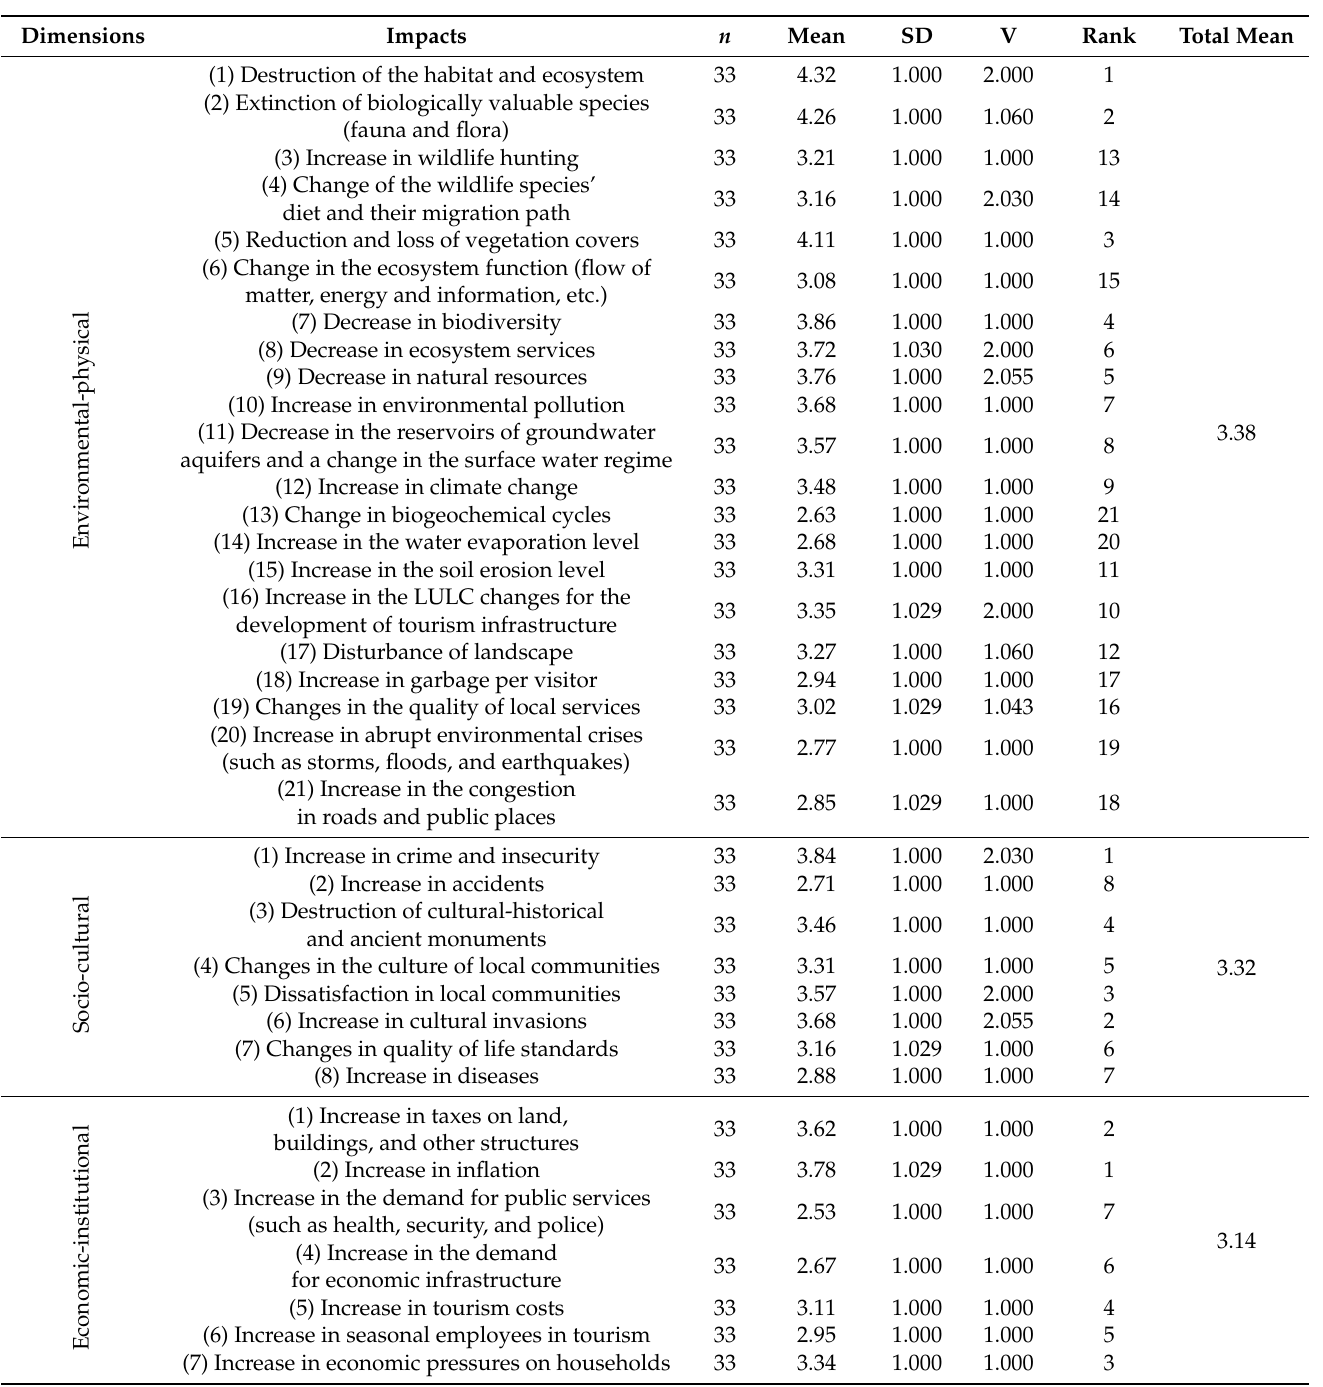
Table 3. Results of round 3 of the Delphi method about the negative impacts of ecotourism in the studied